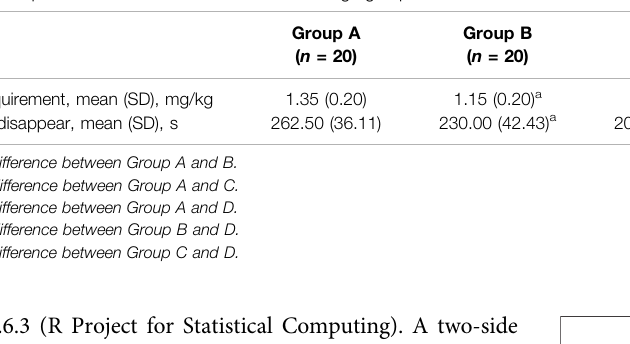
TABLE 2 | Comparison of anesthetic effects in different age groups.